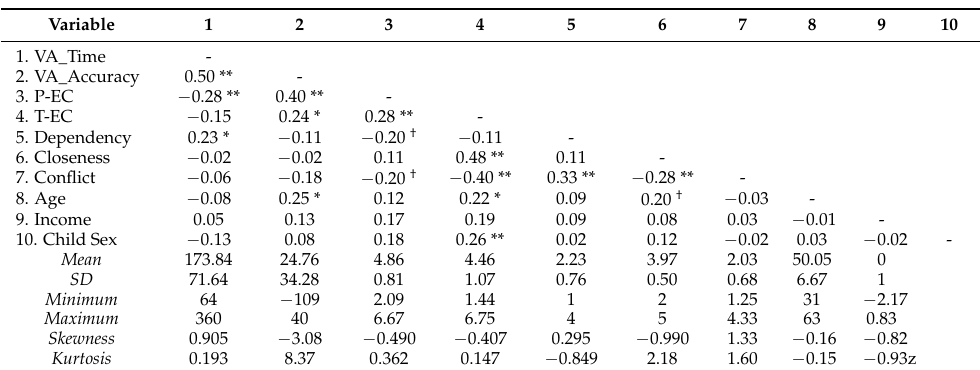
Table 1. Descriptive Statistics and Intercorrelations among Study